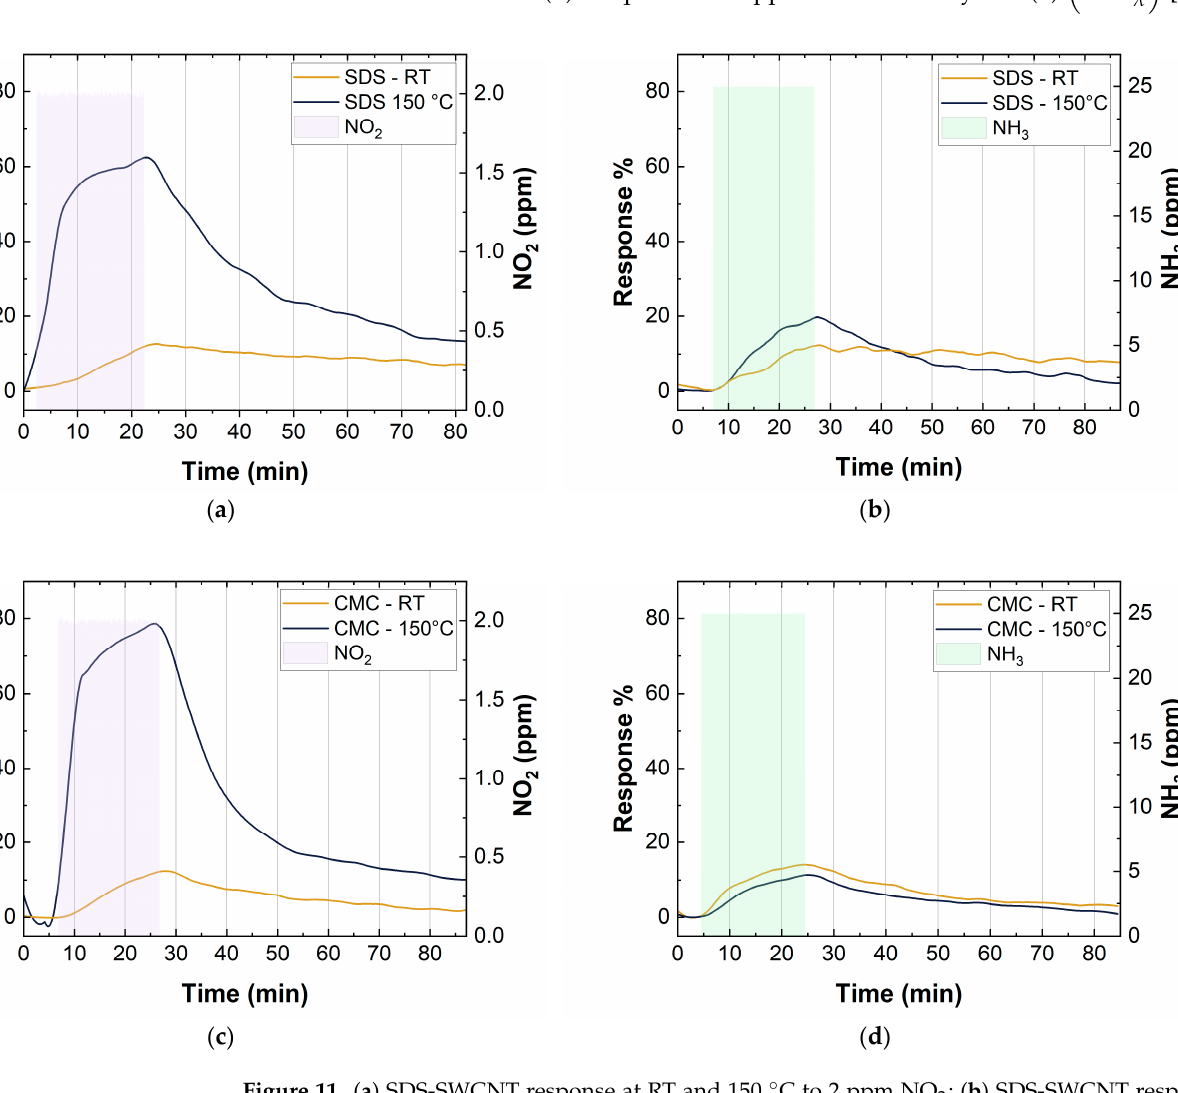
Figure 11. ( a ) SDS-SWCNT response at RT and 150 °C to 2 ppm NO 2 ; ( b ) SDS-SWCNT response at RT and 150 °C to 25 ppm NO 2 ; ( c ) CMC-SWCNT response at RT and 150 °C to 2 ppm NO 2 ; ( d ) CMC-SWCNT response at RT and 150 °C to 25 ppm NO 2 .